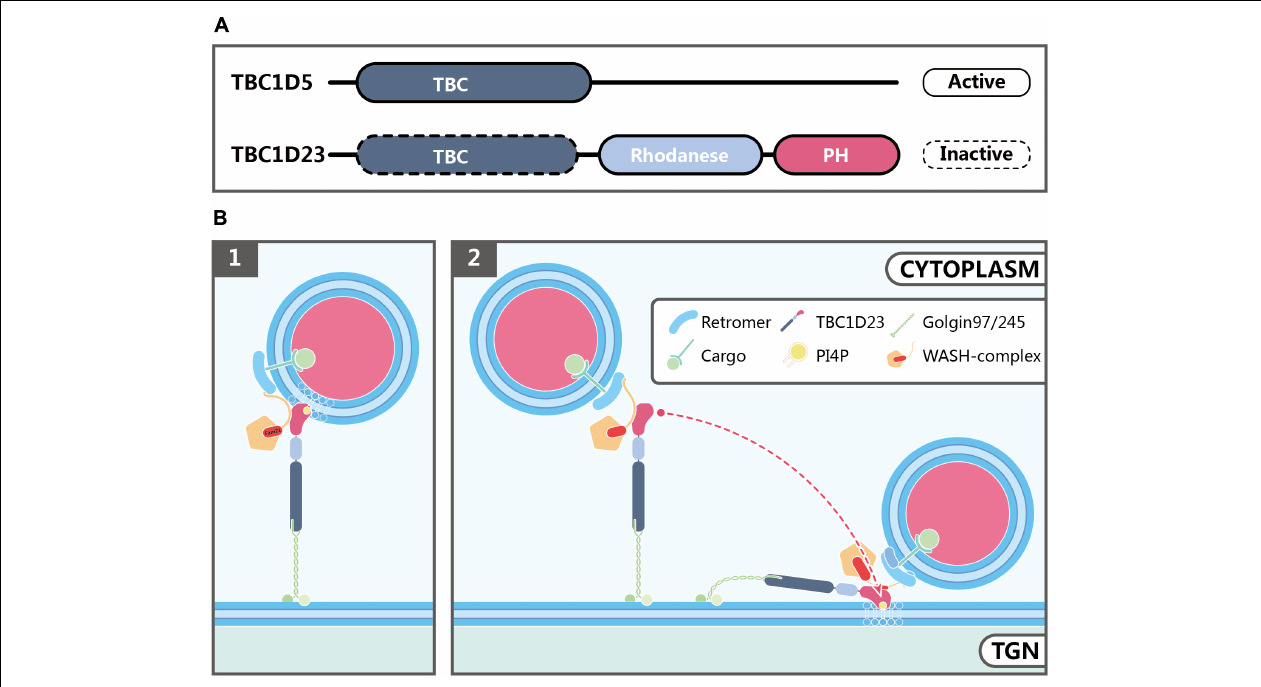
FIGURE 3 | Possible functions of TBC1D23 in endosome-to-TGN trafficking. (A) Domain structures of TBC1D5 and TBC1D23. Although both proteins possess a TBC domain, TBC1D5, but not TBC1D23, is an active GAP for Rab GTPases. In addition to the TBC domain, TBC1D23 also contains a rhodanese-like domain, and a C-terminal domain, which is structurally similar to phospholipid-binding PH domains despite bearing little sequence similarity. (B) Models showing how TBC1D23 regulates endosome-to-TGN trafficking by interacting with FAM21 and specific phosphoinositides, such as PI4P. FAM21 associates with WASH, TBC1D23 and retromer via its N-terminus, the middle region, and C-terminus, respectively. Whereas the C-terminal domain of TBC1D23 engages with PI4P, in addition to FAM21, future studies will be needed to address whether such interactions help to capture the PI4P-positive endosomal vesicles by TBC1D23 (1), or promote the tethering of TBC1D23-bound vesicles to the TGN